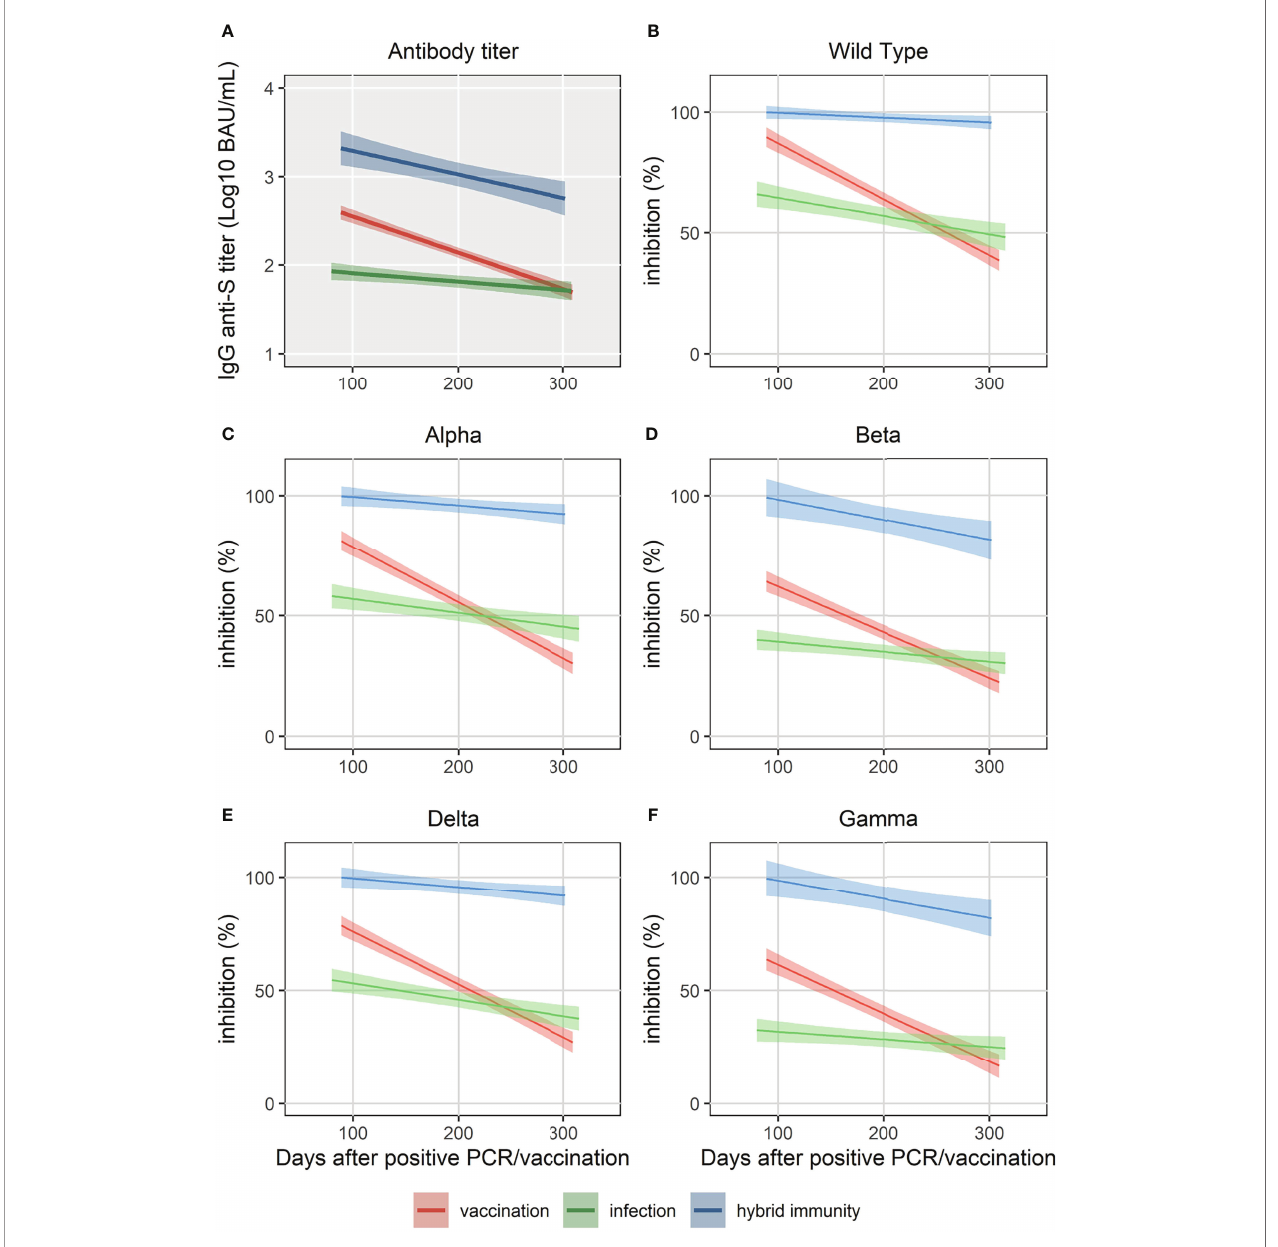
FIGURE 2 | Simple linear regression of IgG anti-S (A) and surrogate neutralizing antibody levels (% inhibition) for WT and 4 VOC (B-F) up to 320